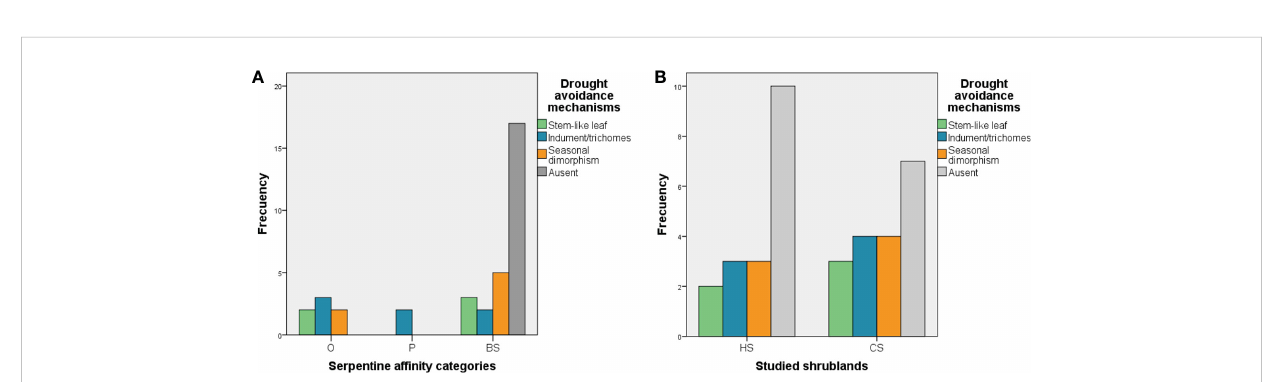
FIGURE 4 (A) Frequency of drought-avoidance mechanisms according to Travlos and Chachalis (2008) between the serpentine af fi nity categories. (B) Frequency of drought-avoidance mechanisms according to Travlos and Chachalis (2008) between the two serpentine types of shrublands. Halimium shrubland (HS) and Cistus shrubland (CS).